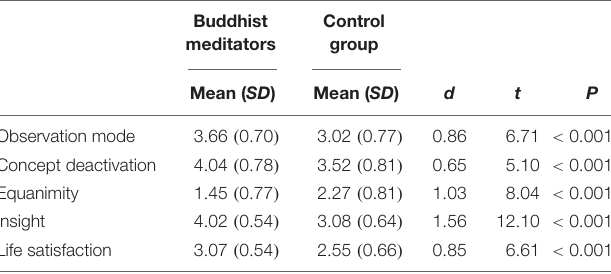
TABLE 3 | Means, standard deviations and t -test statistics for the comparison between Buddhist meditators ( N = 102) and the non-meditating control group ( N =